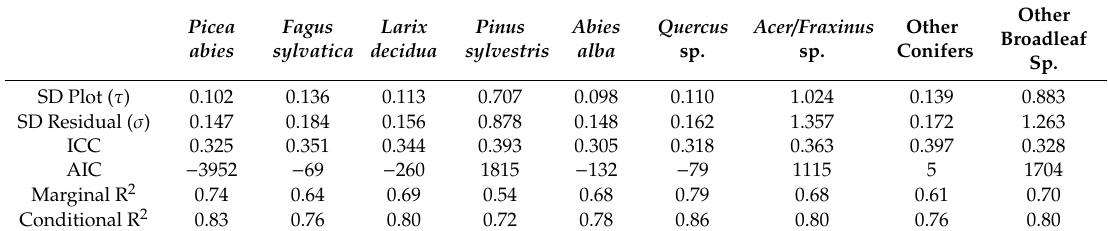
- Table 4. Variance parameters and evaluation indices of the mixed-e ff ect CW models for the di ff erent tree species. ICC is the intraclass correlation coe ffi cient and AIC the Akaike information criterion. Picea Fagus Larix Pinus Abies Quercus Acer / Fraxinus Other abies sylvatica decidua sylvestris alba sp. sp. Conifers